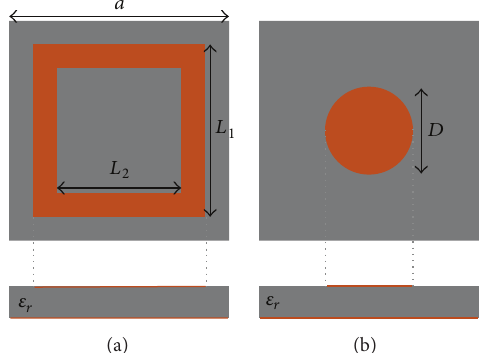
Figure 1: Two unit cells: (a) square ring patch and (b) small circular patch. Dimensions are in mm: 𝑎 = 2.6 , 𝐷 = 1 , 𝐿 1 = 1.6 , and 𝐿 2 = 2.4 .